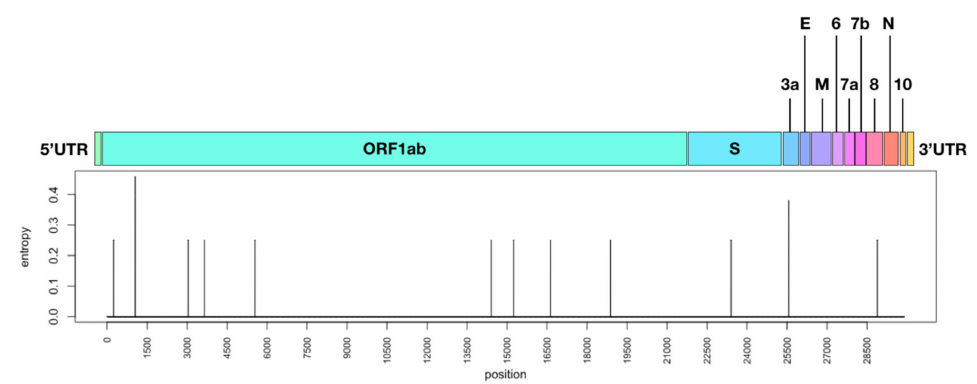
Figure 2. Diversity of mutations along the SARS-CoV-2 whole genome. All mutations observed along the genomeandtheirfrequency,asdeterminedbynormalizedentropy,whereentropy = 0representsaninvariable site and entropy = 1 represents a site where all states occur with equal probability.